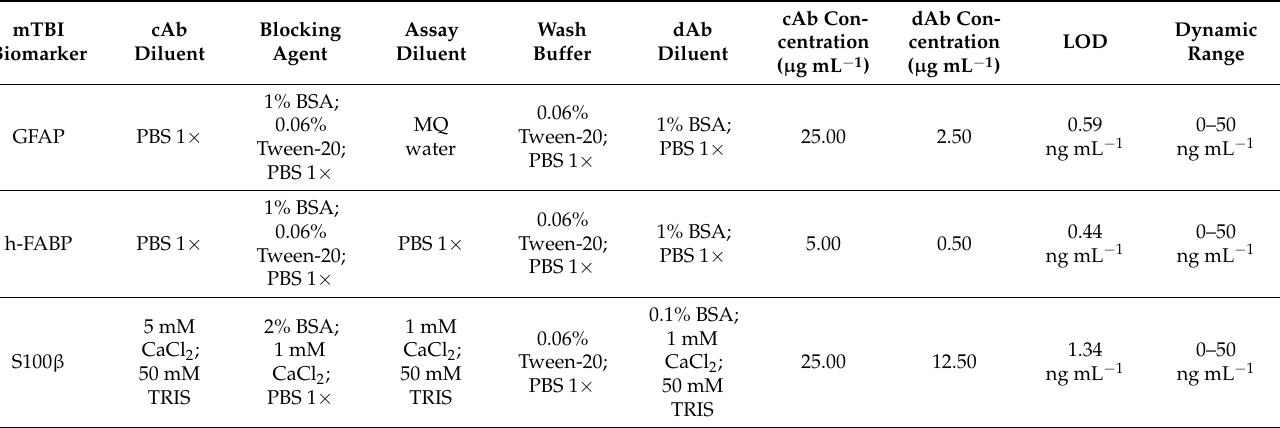
Figure 3. ( a ) Linear sweep voltammogram of SPCE for h-FABP biomarker assay (scan rate 200 mV/s) (black curve) and generated ECL signal (red curve). ( b ) ECL intensity curves from h-FABP biomarker assay on SPCE generated by chronoamperometry at different potentials: 1.4; 1.5; 1.55 and 1.6 V. Acquisition time 10 s. h-FABP assay conditions in Table 4 below (antigen concentration 100 ng mL − 1 ). Table 4. Preliminary conditions evaluated on SPCE using µ STAT-ECL platform for each individual mTBI biomarker ECL sandwich immunoassay ( singleplex